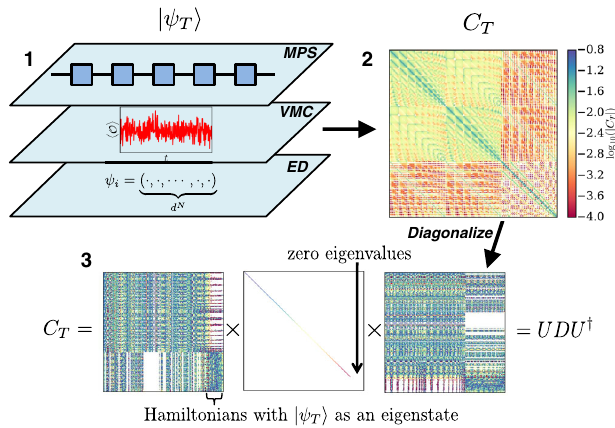
FIG. 3. The steps of EHC. (1) Represent the target state j ψ T i numerically using, for example, MPS, VMC, or ED techniques. (2) Compute the QCM C T given by Eq. (1). (3) Diagonalize the QCM numerically to obtain the eigendecomposition C T ¼ UDU † . The columns of U are eigenvectors of C T and the diagonal entries of D are their corresponding eigenvalues. The null vectors, i.e., eigenvectors with zero eigenvalue, correspond to the coupling constants of Hamiltonians with j ψ T i as an energy eigenstate. The C T matrix depicted is the QCM for the XX chain ground state used in our phase expansion